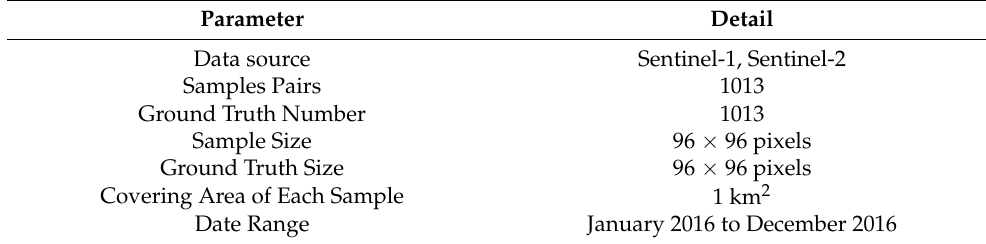
Table 2. Key parameters of the proposed large-scale multi-source river imagery